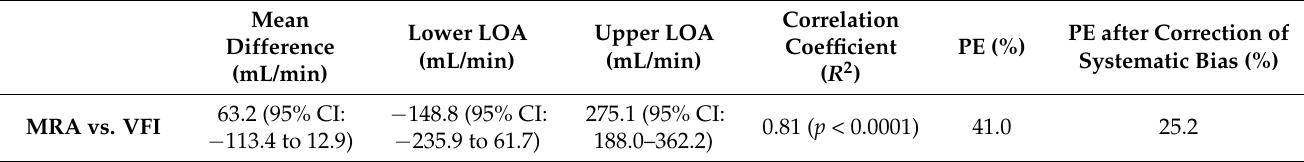
Table 2. Mean differences, lower/upper limits of agreements (LOAs), percentage errors (PEs), and correlation coefficients for comparisons between VFI and